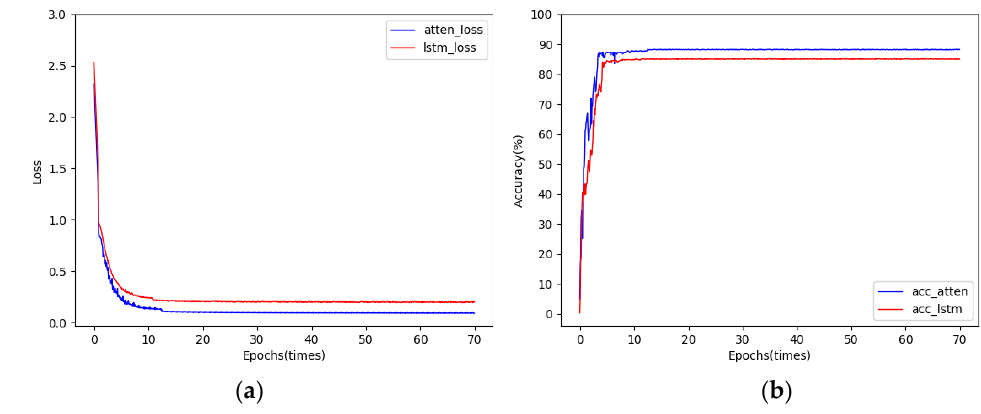
Figure 8. Comparison of our proposed attention-based model (blue) with CNN-LSTM model (red). ( a ) Comparison of losses between the two networks and ( b ) comparison of the accuracies between the two networks.